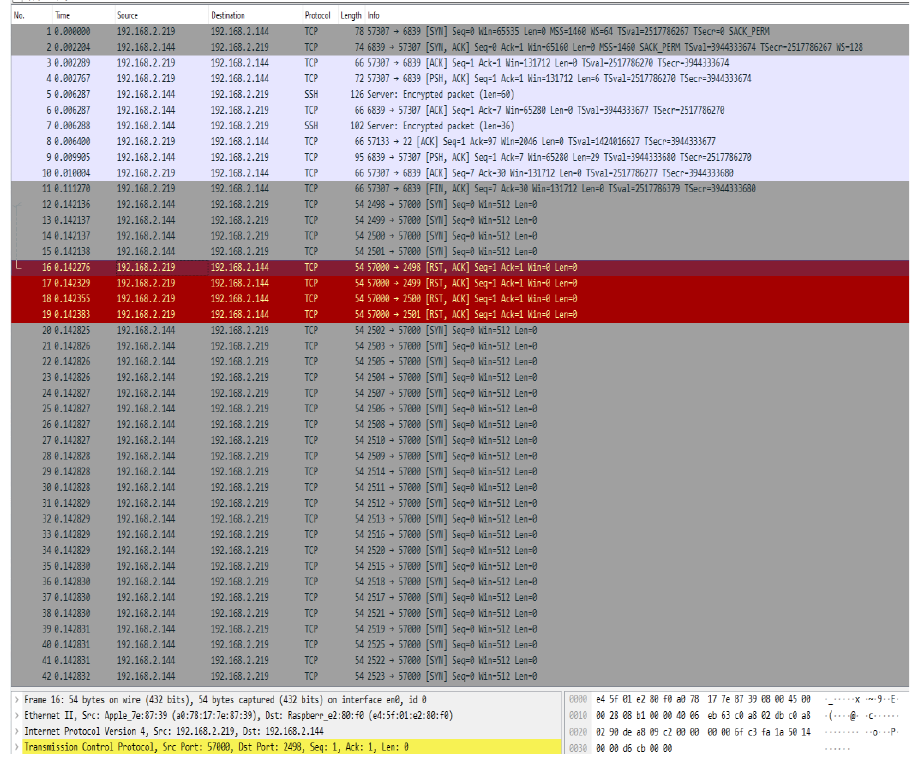
Figure 5. A SYN flood attack on the victim server.